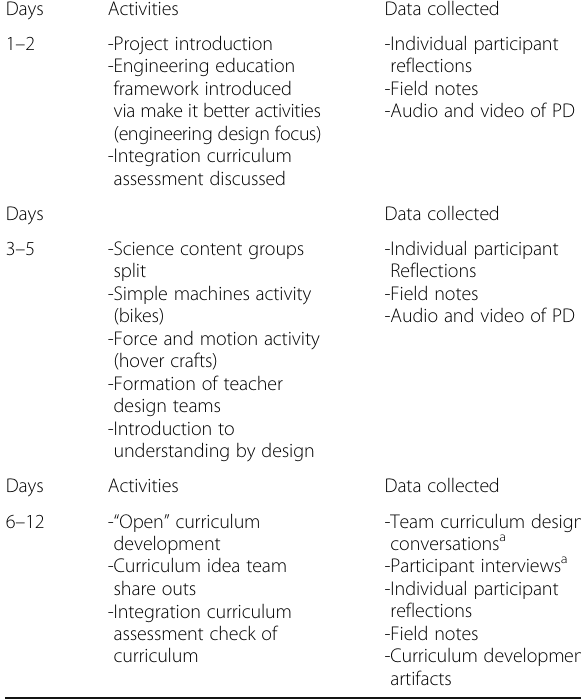
Table 2 Professional development overview and